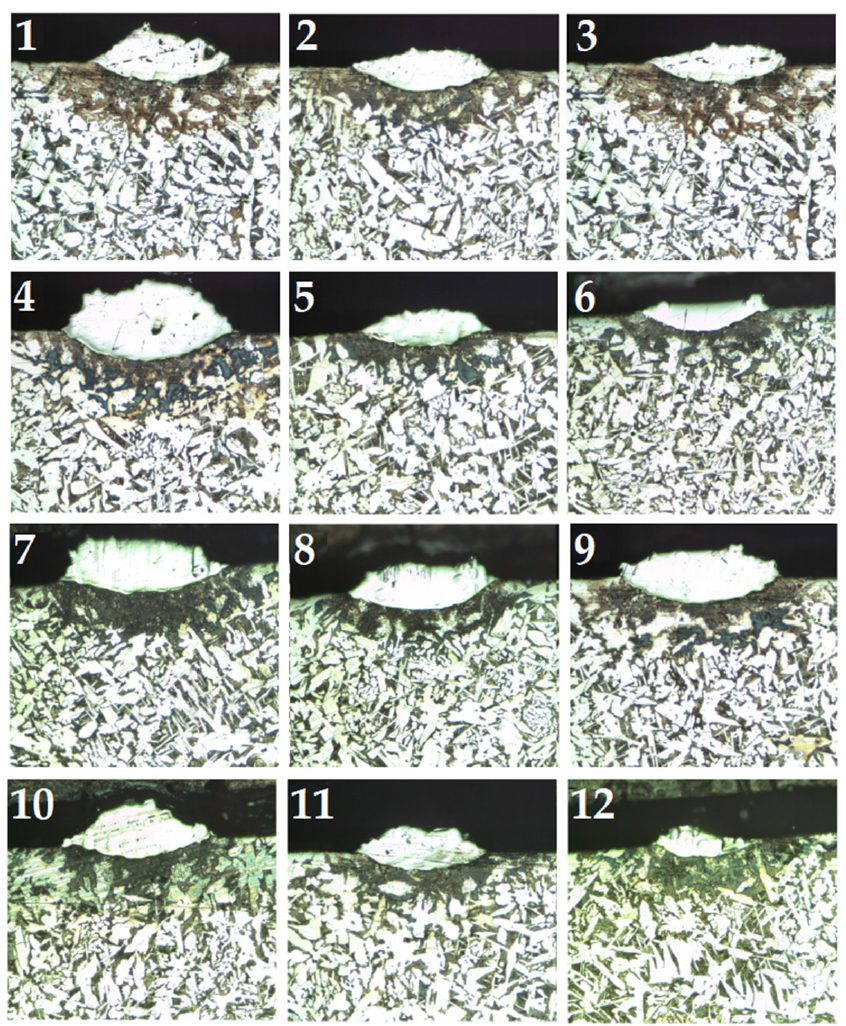
Figure 7. Cross-section images of single beads at different LDED parameters. Bead numbers are according to the Table 5. Table 5. Hardness of the Mo coatings depending on the LDED working parameters. Bead No.